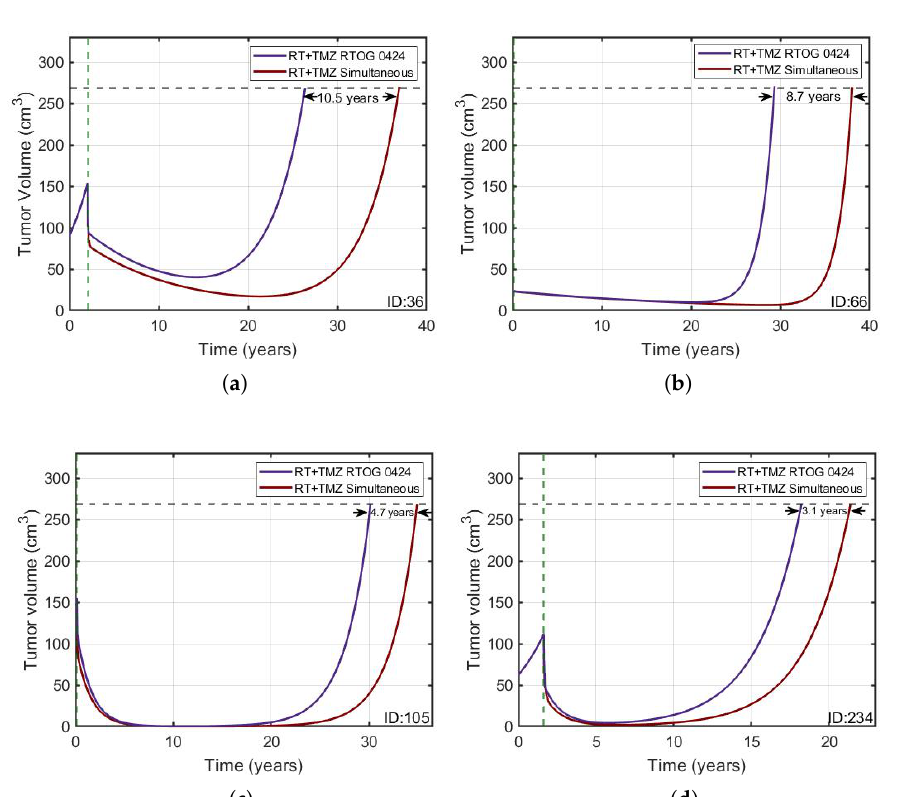
( d ) Figure 8. ( a – d ) Simulated tumor growth curves for patient 36 and for three in-silico patients treated according to RTOG 0424 (purple solid line) and the RT+TMZ simultaneous (red solid line) regimens. Treatment onset is denoted by a vertical green dashed line and the fatal tumor volume by a horizontal black dashed line. Table 4. Real (in black, see Table 3) and virtual (in blue) values of the parameters related to therapies and the numbers of TMZ cycles and RT sessions received for the patients included. α 1 and α 2 are measured in cm 3 / ( µ g day ) . The final column corresponds to the overall survival gain (OSG) for each